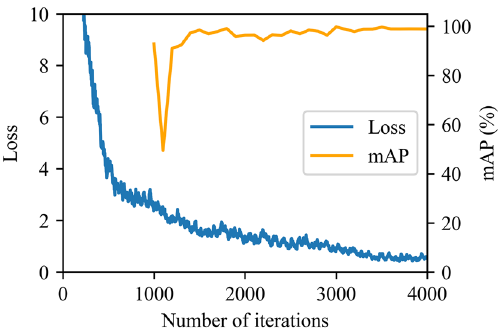
Figure 10. YOLOv3 object detection model training process.